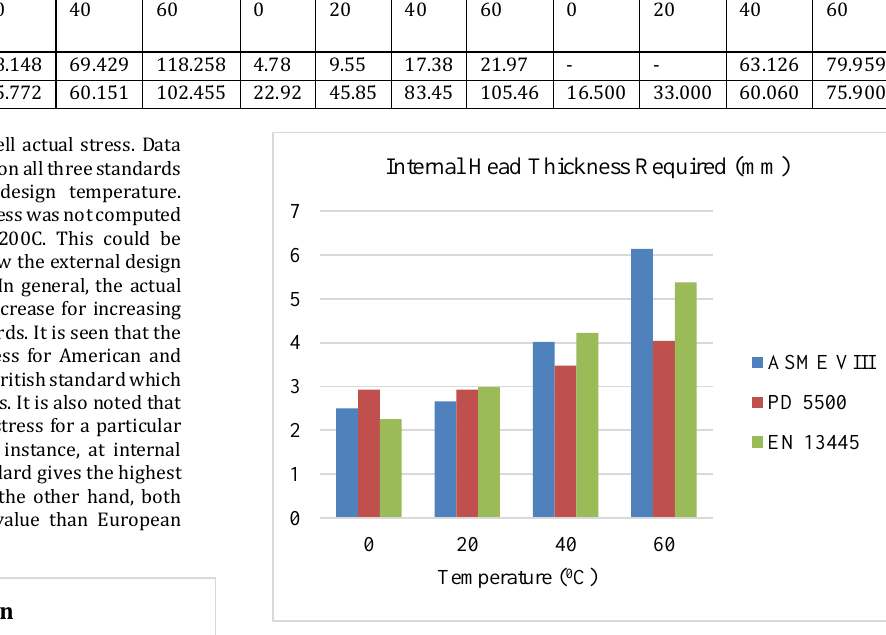
Figure 3: Internal head required thickness